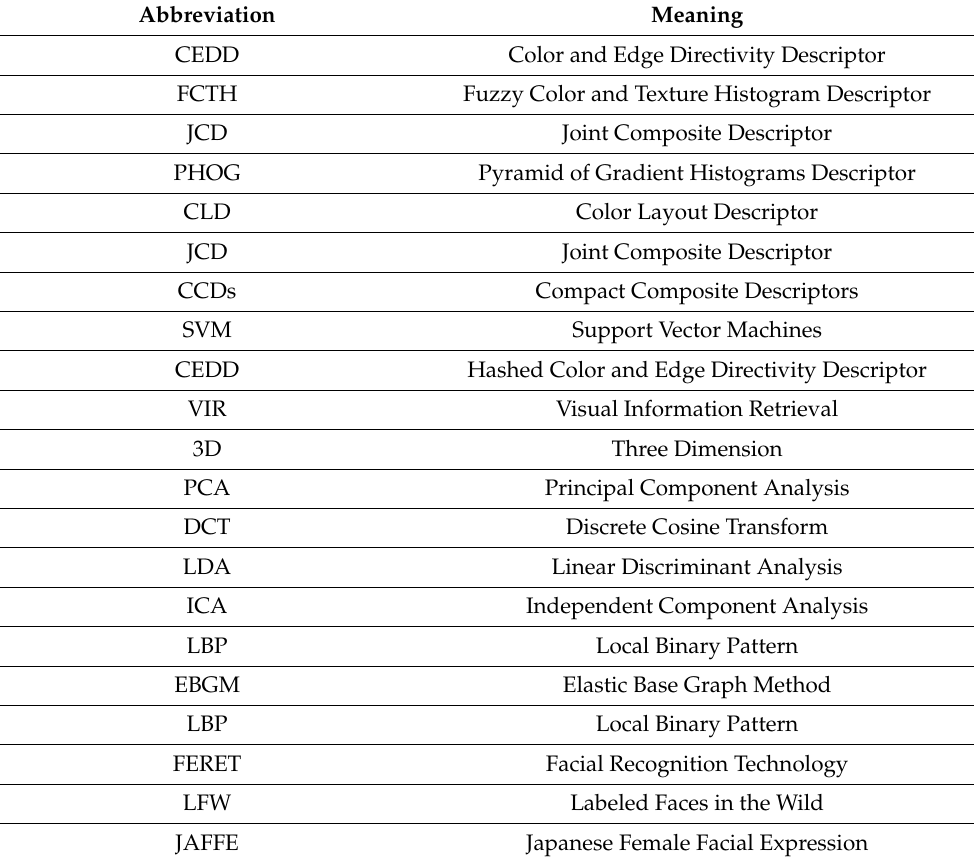
Table 1. List of